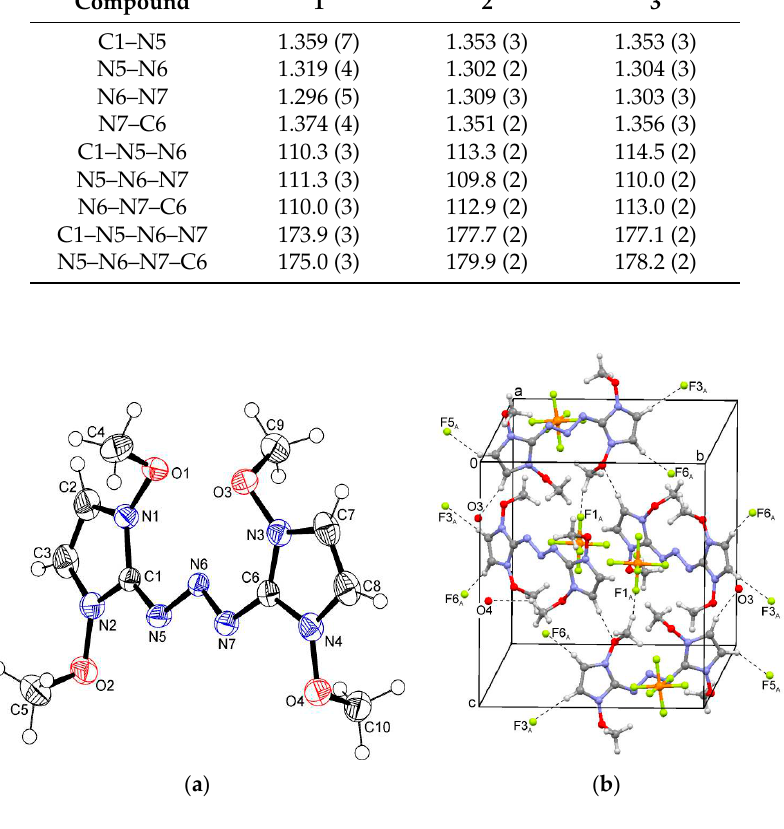
( b ) Figure 4. ( a ) molecular structure of the cation; ( b ) interactions in the crystal structure of 3 . 2.2. UV-Vis Spectroscopy Typically, donor–acceptor-substituted conjugated systems exhibit solvatochromism. The solvatochromism of such systems arises from the different stabilization of their electronic ground and excited state by differential solvation of these two states, according to their different molecular and electronic structure. Transition energies E T were calculated from the wavelengths of the absorption maxima (Table 4) according to the equation E T /kJ·mol − 1 = hcN / λ = 119625/( λ /nm). A linear solvation energy relationship was established by least-squares fitting the data to the solvatochromic equation involving the parameters π * [21] and α [22] which represent the dipolarity/polarizability and hydrogen-bond donor capabilities of the solvent.The hydrogen-bond acceptor basicity β [23] did not significantly contribute to the relationship. The following equations were derived by multiple linear regression (Figure 5), which adequately describe the solvatochromic behavior of the triazenes. For 1 : E T /kJ·mol − 1 = 291.7 + 3.98 π * + 8.61 α ( n = 7, R 2 = 0.992) For 2 : E T /kJ·mol − 1 = 313.2 − 9.21 π * − 5.08 α ( n = 6, R 2 = 0.960) For 3 : E T /kJ·mol − 1 = 317.96 + 3.32 π * + 8.15 α ( n = 6, R 2 = 0.960)